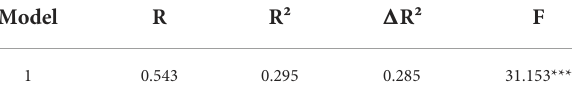
TABLE 10 Summary of the flourishing